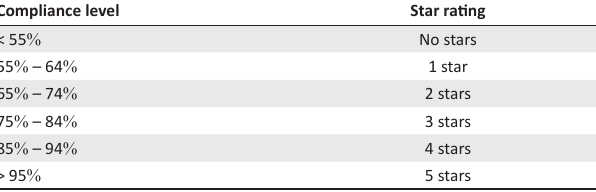
TABLE 1: Stepwise Laboratory Quality Improvement Process Towards Accreditation checklist compliance levels versus star ratings. Compliance